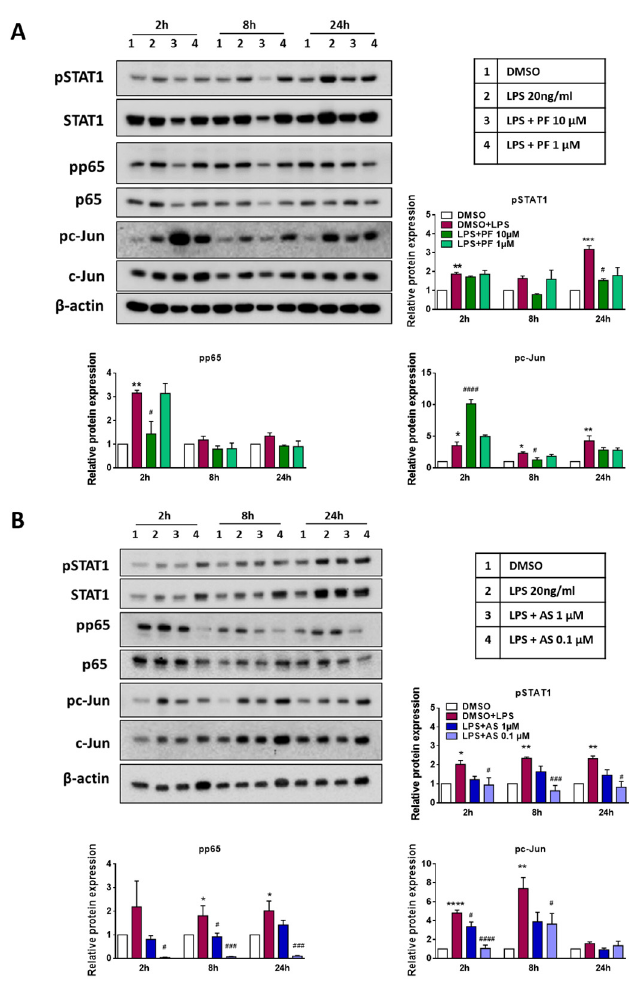
Figure 3. Inhibition of ATX and LPA5 regulates LPS-induced transcription factor phosphorylation . Cells were treated with DMSO (vehicle control), LPS (20 ng/mL) plus DMSO, and ( A ) LPS plus PF8380 (‘PF’; 10 and 1 µM) or ( B ) LPS plus AS2717638 (‘AS’; 1 and 0.1 µM) for the indicated times. Cell lysate were collected and protein expression of phosphorylated STAT1, p65, and c-Jun along with their total protein was monitored using immunoblotting. β -actin was used as loading control. One representative blot for each protein is shown. Densitometric evaluation of immunoreactive bands is shown in the bar graphs. Values are expressed as mean ± SEM of three independent experiments. (* p < 0.05, ** p < 0.01, *** p < 0.001, **** p < 0.0001 compared to DMSO control; # p < 0.05, ### p < 0.001, #### p < 0.0001 compared to LPS-treated cells; one-way ANOVA with Bonferroni correction).